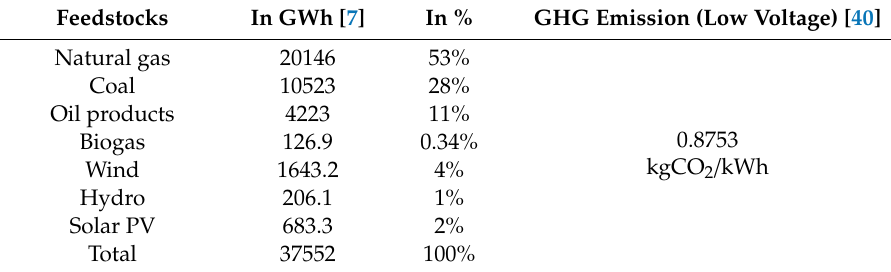
Table 2. Electricity generation mix in Western